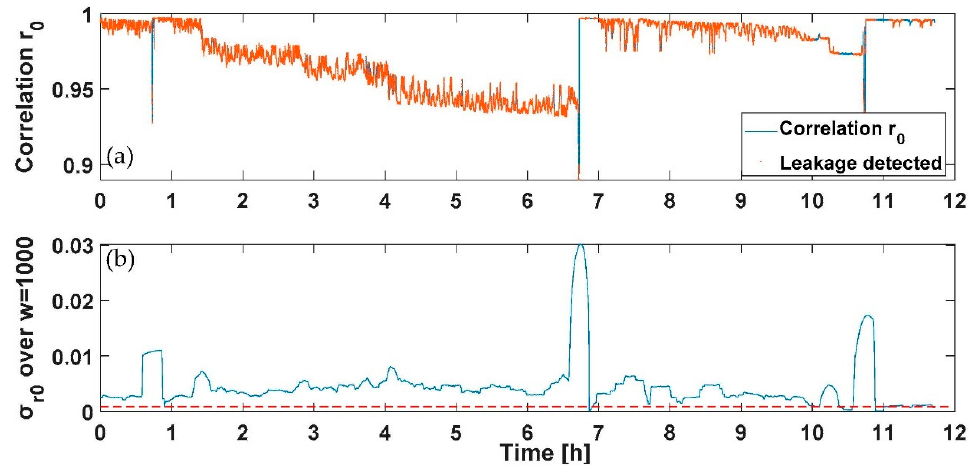
Figure 12. Test on dynamic profile with a continuous leakage for the piston water meter: ( a ) the r 0 correlation and the point detected corresponding to consumption in red, and ( b ) the moving average σ r0 and in red the threshold retrieved from Table 3 to discriminate a flow rate different from zero.